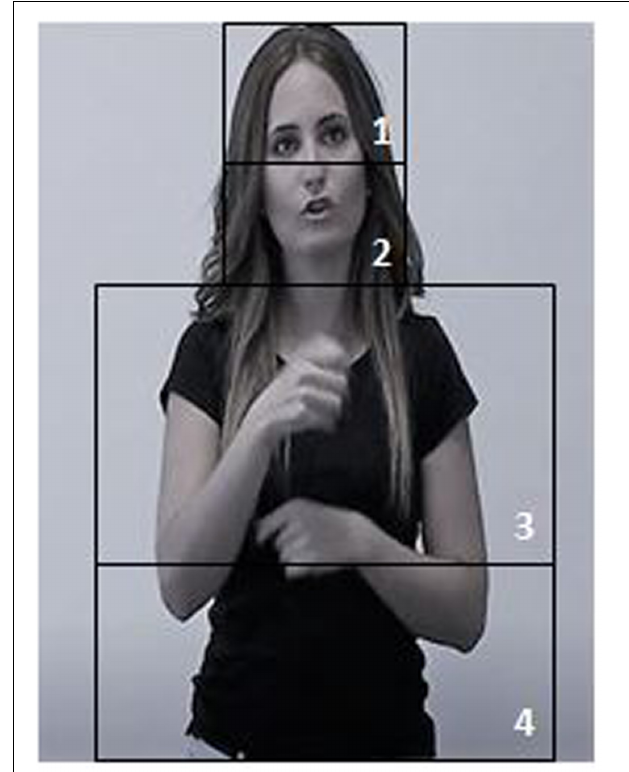
FIGURE 2 | Interest areas on the signer’s body: 1 = Upper face; 2 = Lower face; 3 = Upper body; 4 = Lower